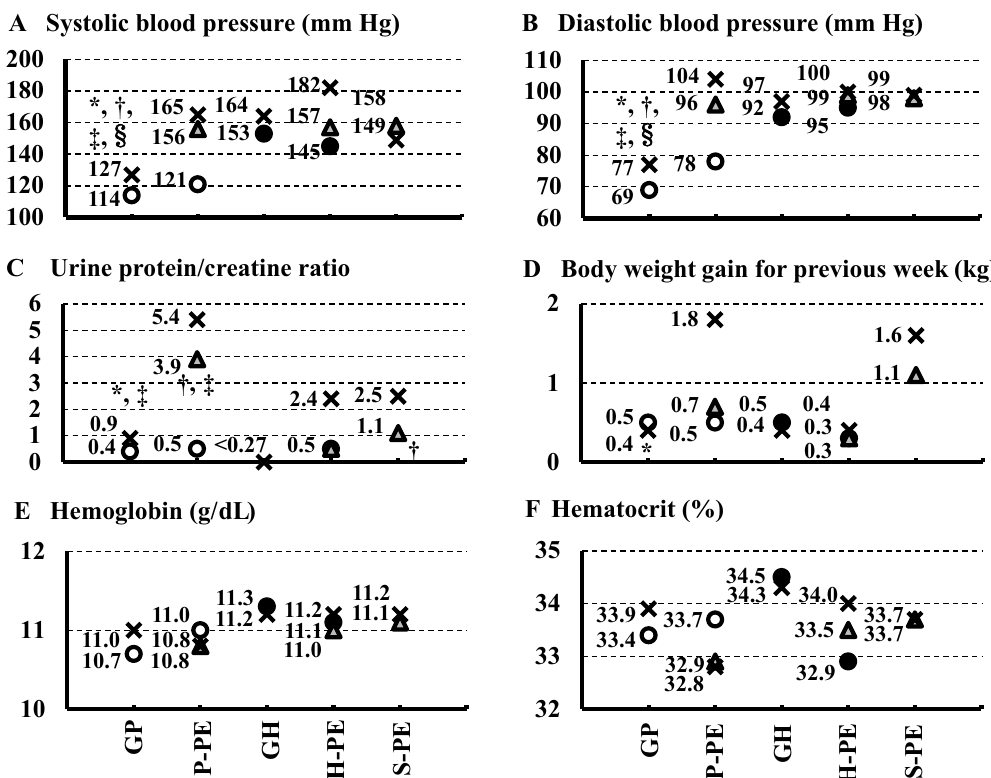
Figure 1. Trends of laboratory findings at onset of gestational proteinuria (GP) or gestational hypertension (GH), onset of preeclampsia, and delivery: systolic blood pressure ( A ), diastolic blood pressure ( B ), urine protein/creatine ratio ( C ), body weight gain for last 1 week ( D ), hemoglobin ( E ), and hematocrit ( F ). All data shown are median values. ○ , at GP onset (appearance of proteinuria); hypertension); ▲ , at preeclampsia onset (hypertension plus proteinuria); ×, at delivery. *P < 0.05 versus proteinuria preceding preeclampsia (P-PE); † P < 0.05 versus hypertension preceding preeclampsia (H-PE); ‡ P < 0.05 versus simultaneous onset of proteinuria and hypertension before preeclampsia (S-PE); § P < 0.05 versus